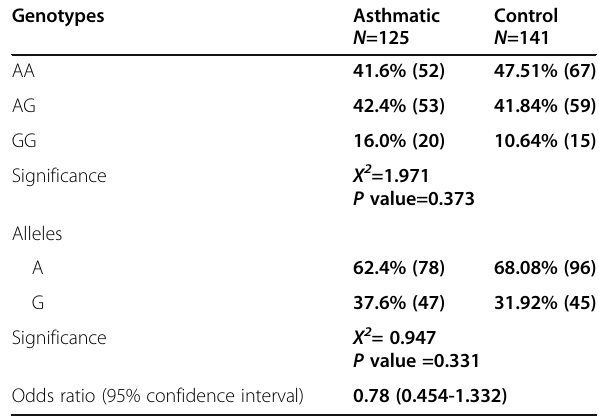
Table 3 The distribution of rs2305480 ( GSDMB gene) polymorphism genotype and allele frequencies in the